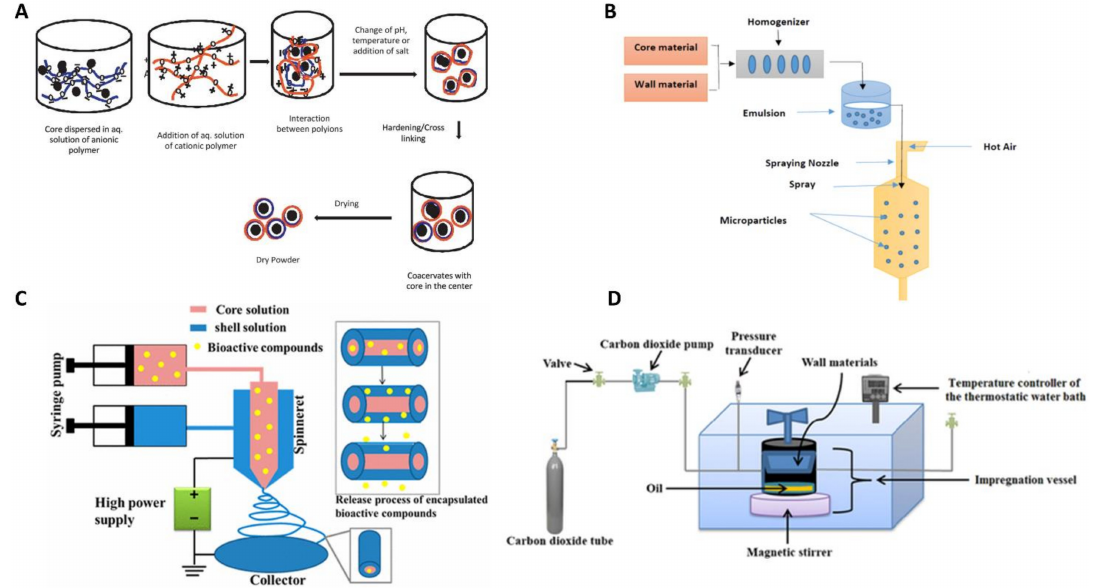
Figure1. Schematic representation of the micro / nanoencapsulation process by ( A ) complexcoacervation, ( B ) spray-drying, ( C ) coaxial electrospinning and ( D ) supercritical fluid technology (image adapted from